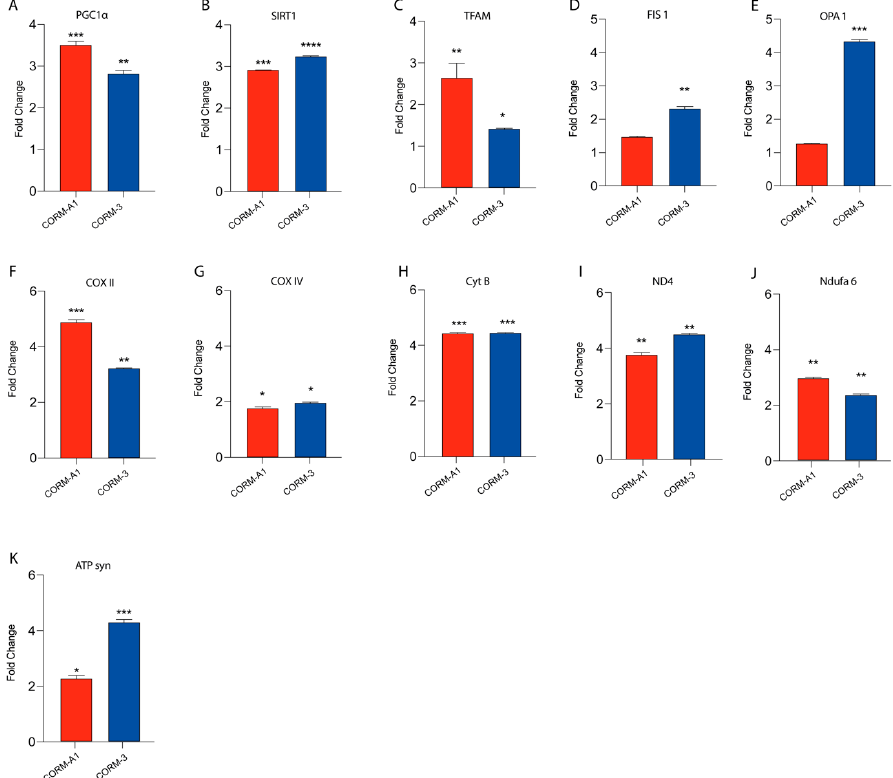
Figure 4. CORMs (24 μ M for 24h) supplementation increases 92.1 mitochondrial fitness. ( A – K ) qPCR analysis unveils an increased expression of genes involved in UM mitochondrial fitness. ( A ) PGC1 α , ( B ) SIRT1, ( C ) TFAM, ( D ) FIS1, ( E ) OPA1, ( F ) COX II, ( G ) COX IV, ( H ) CytB ( I ) ND4, ( L ) Ndufa6, and ( M ) ATP syn show an increase in expression upon CORM-A1 and